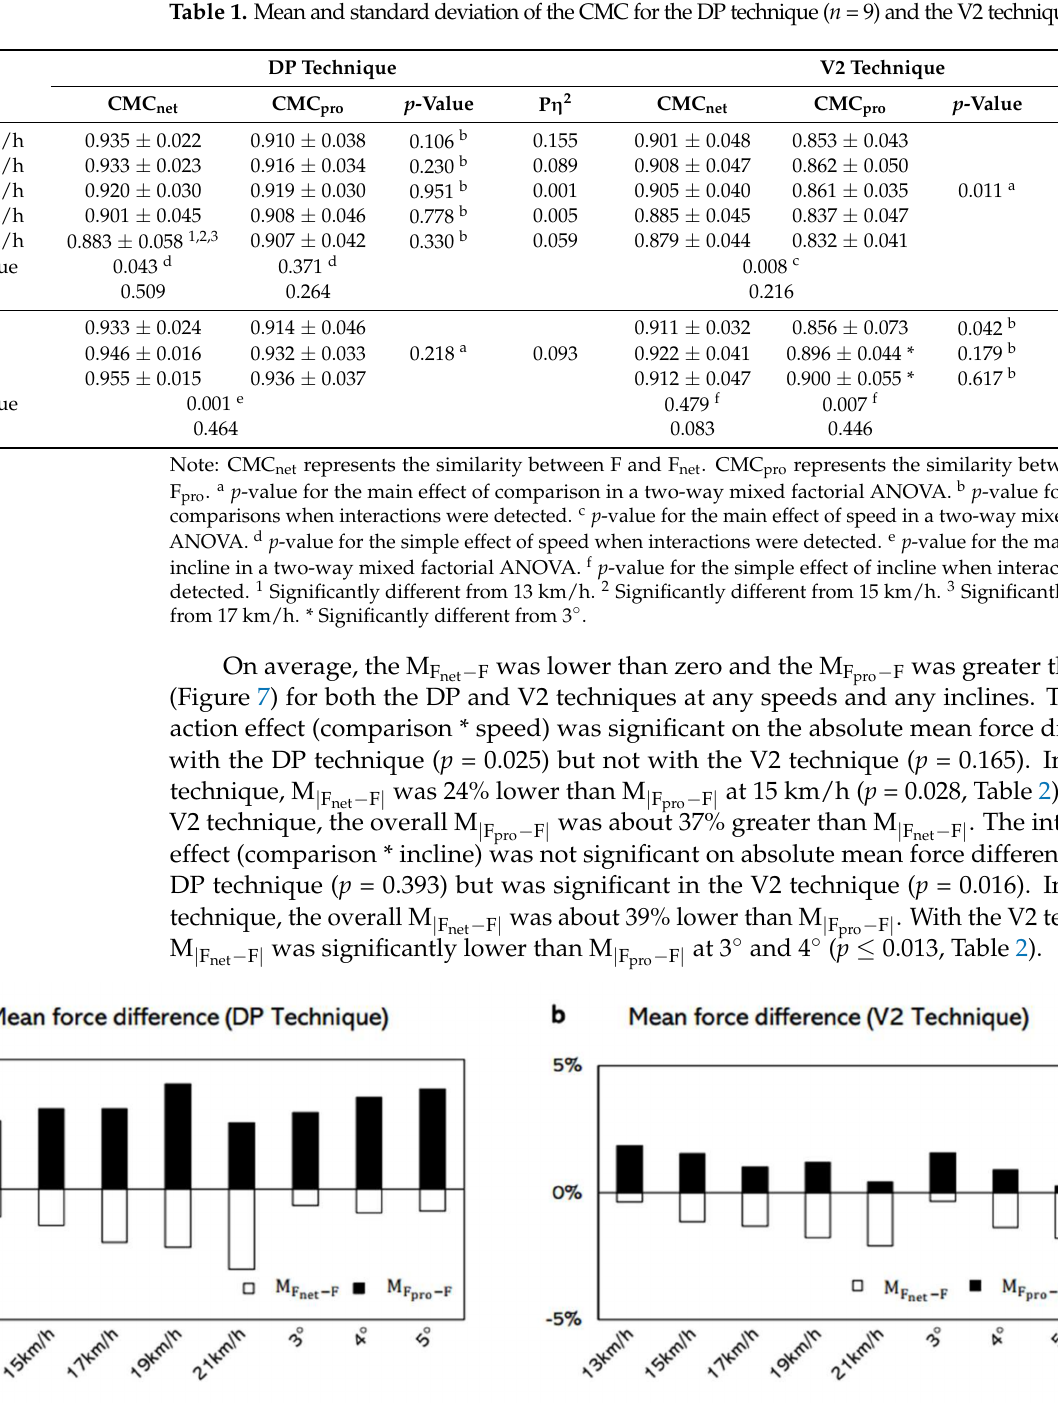
Figure 7. Mean force difference over force producing phases in DP and V2 techniques (%BW). M F net − F represents the difference between F and F net and is calculated by F–F net . M F lower than zero net − F indicates that F net is greater than F. M F represents the difference between F and F pro and is pro − F calculated by F–F pro . M F greater than zero indicates that F pro is lower than pro − F